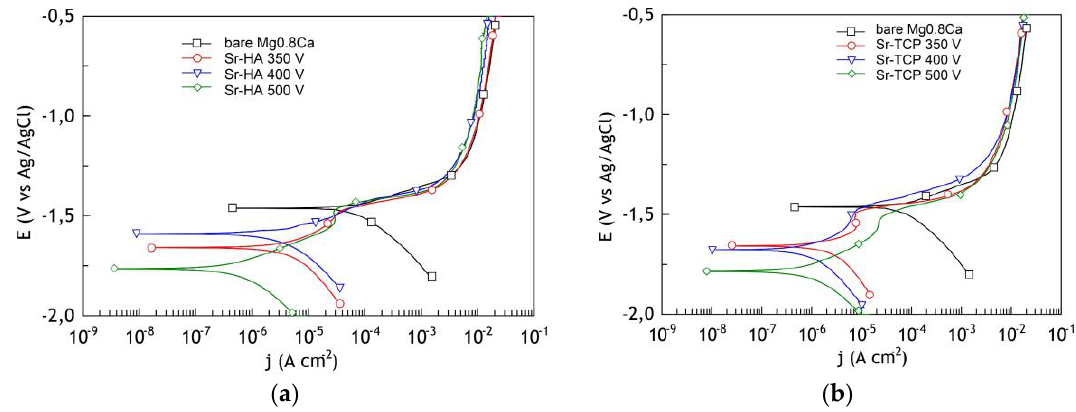
Figure 11. Potentiodynamic polarization (PDP) curves for bare Mg0.8 alloy, Sr-HA ( a ) and Sr-TCP ( b ) coatings recorded in 0.9% NaCl.